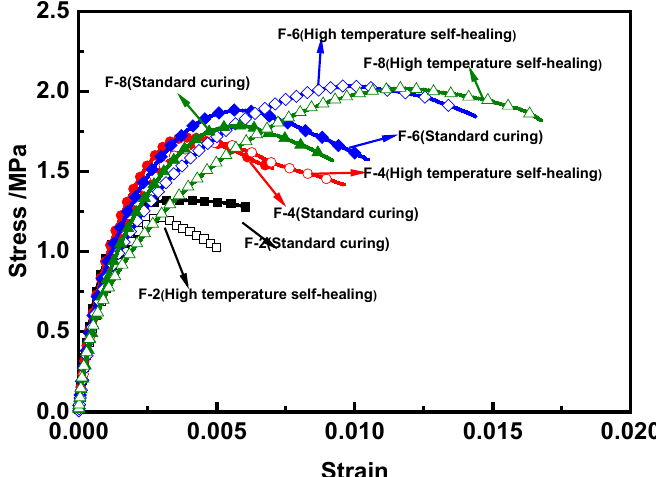
Figure 13. Stress-strain curve of the flexible curing agent stabilized silt under standard curing and high temperature.